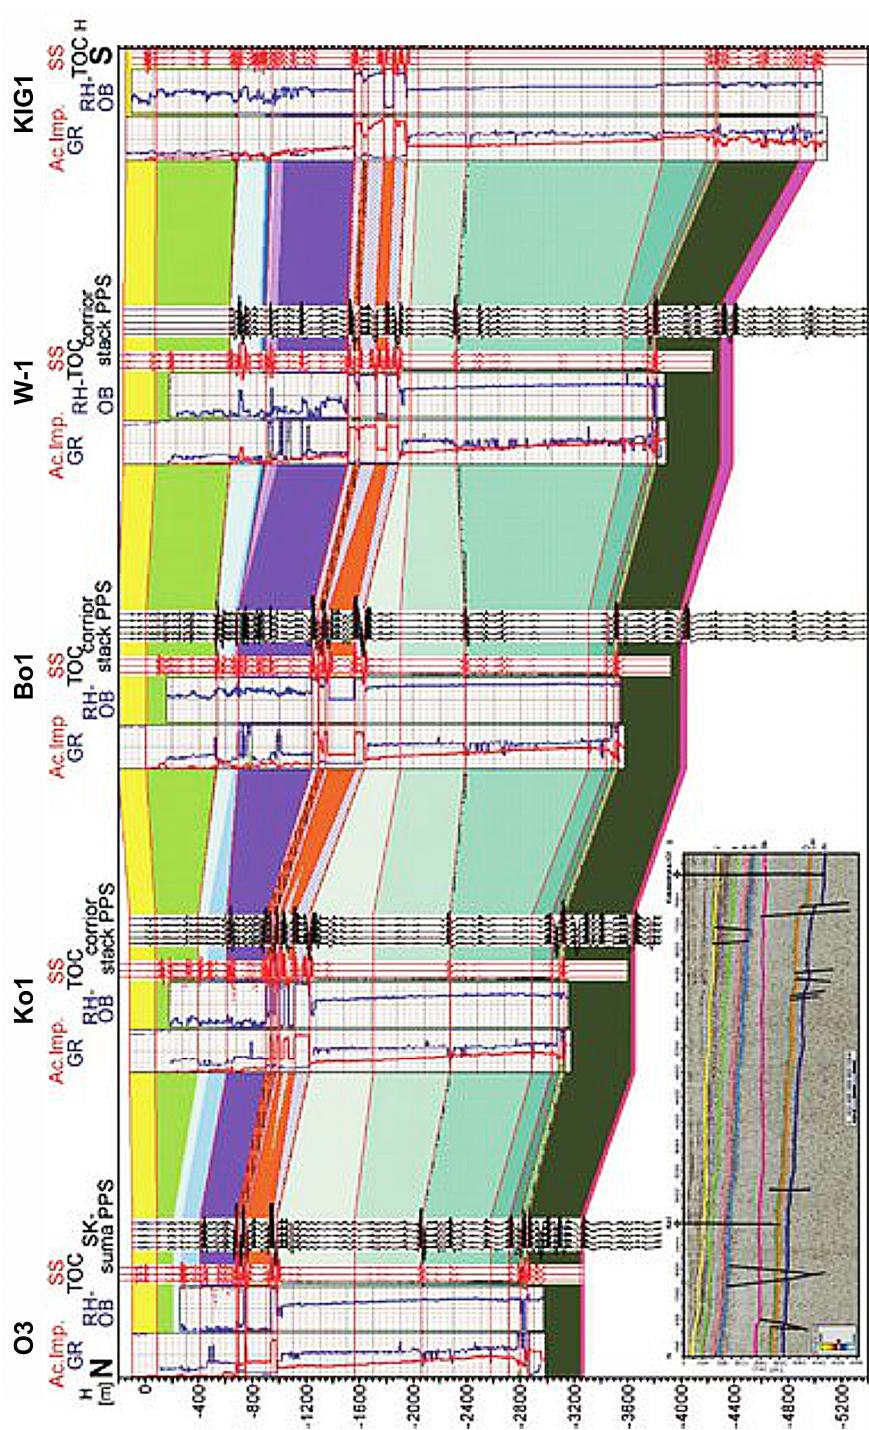
Figure 3. Lithostratigraphic well correlation section between wells O3, Ko1, Bo1, KIG1, and Well W-1, together with a structural interpretation of seismic data (see in [8]